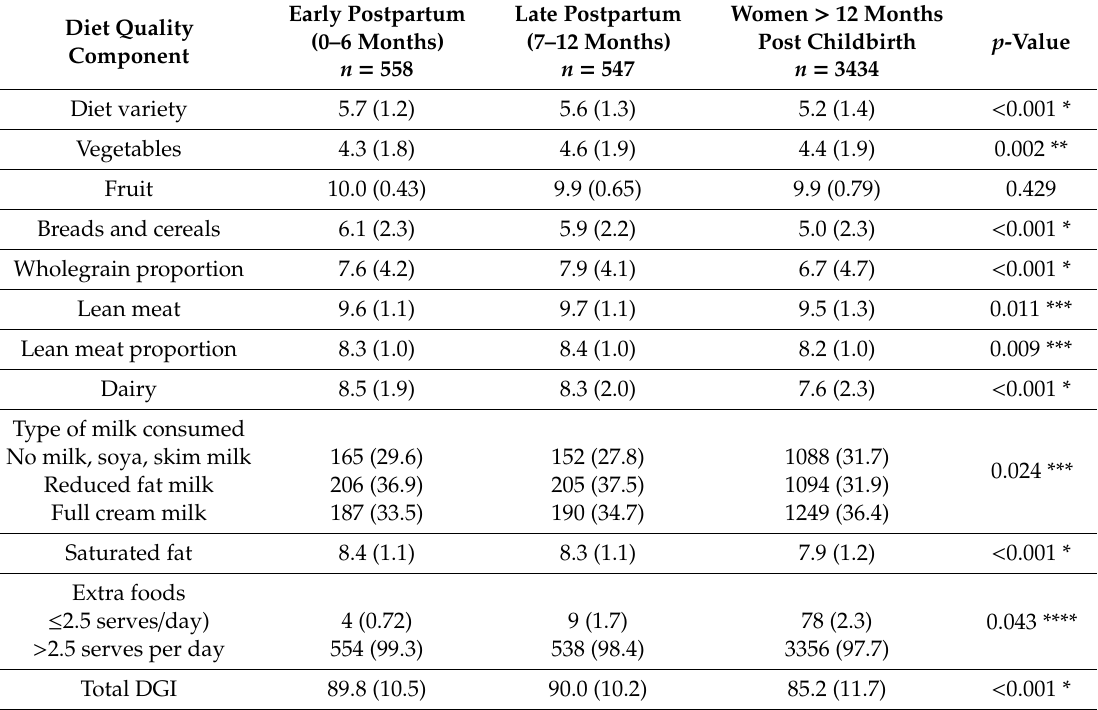
Table 3. Total diet quality and its components in women categorized by their time since